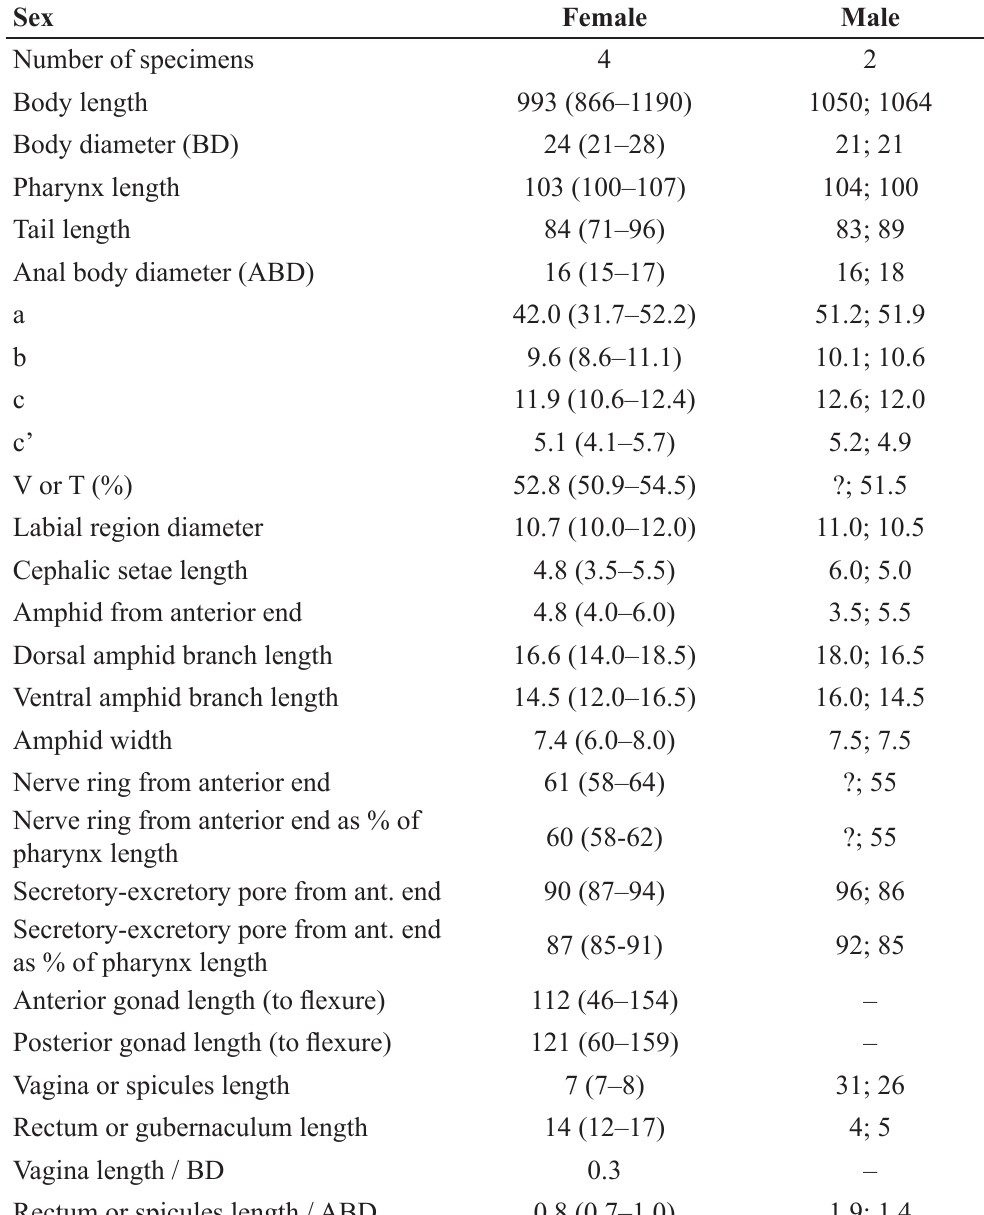
Table 2. Measurements (in µm) of Diplopeltoides asetosus (Juario, 1974) comb. nov., presented as mean and (range) for females and each male individual measurement separated with a semicolon; “?” indicates that the character can not be observed or